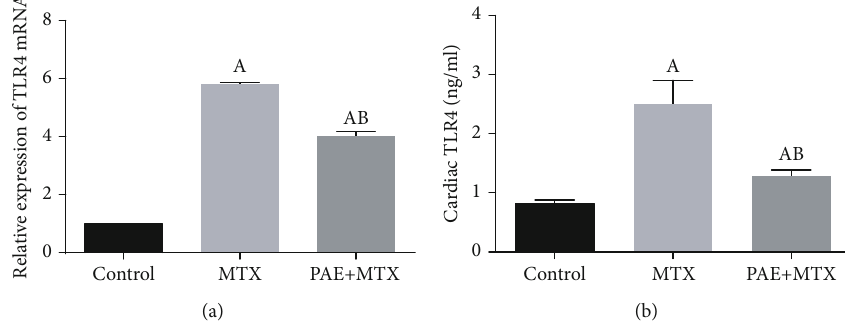
Figure 2: E ff ect of paeonol (PAE) on cardiac Toll-like receptor 4 (TLR4) mRNA expression (a) and protein level (b) in methotrexate- (MTX-) induced cardiac toxicity in rats. All parameters are expressed as means ± SEM . “ A ” means signi fi cantly di ff erent from the control group and “ B ” means signi fi cantly di ff erent from the MTX-treated group, at p < 0 : 05